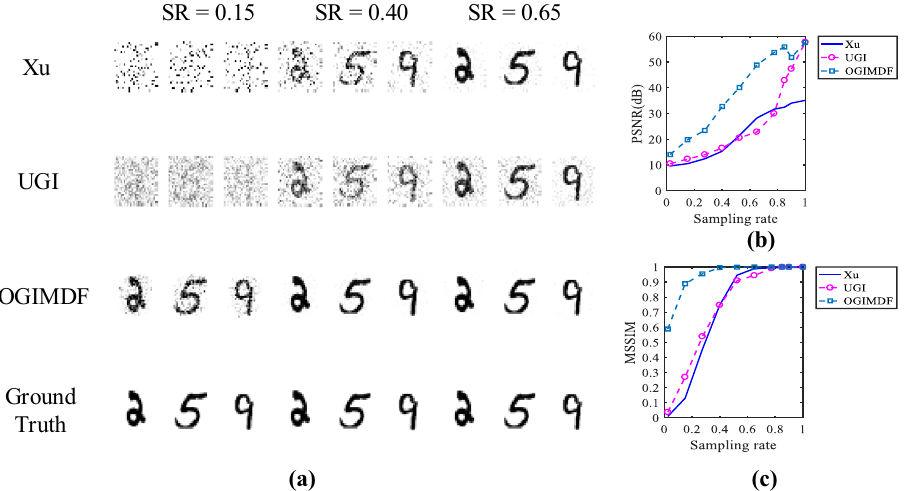
Figure 2. Simulation results of three schemes under different SRs. ( a ) The images in the first row are reconstructed using Xu method, the second row shows the images reconstructed using UGI, the third row shows the restored objects using OGIMDF, and the images in the last row are the ground truth. ( b ) and ( c ) show the change curves of PSNR and MSSIM of reconstructed images using Xu, UGI and OGIMDF under different SRs, respectively.